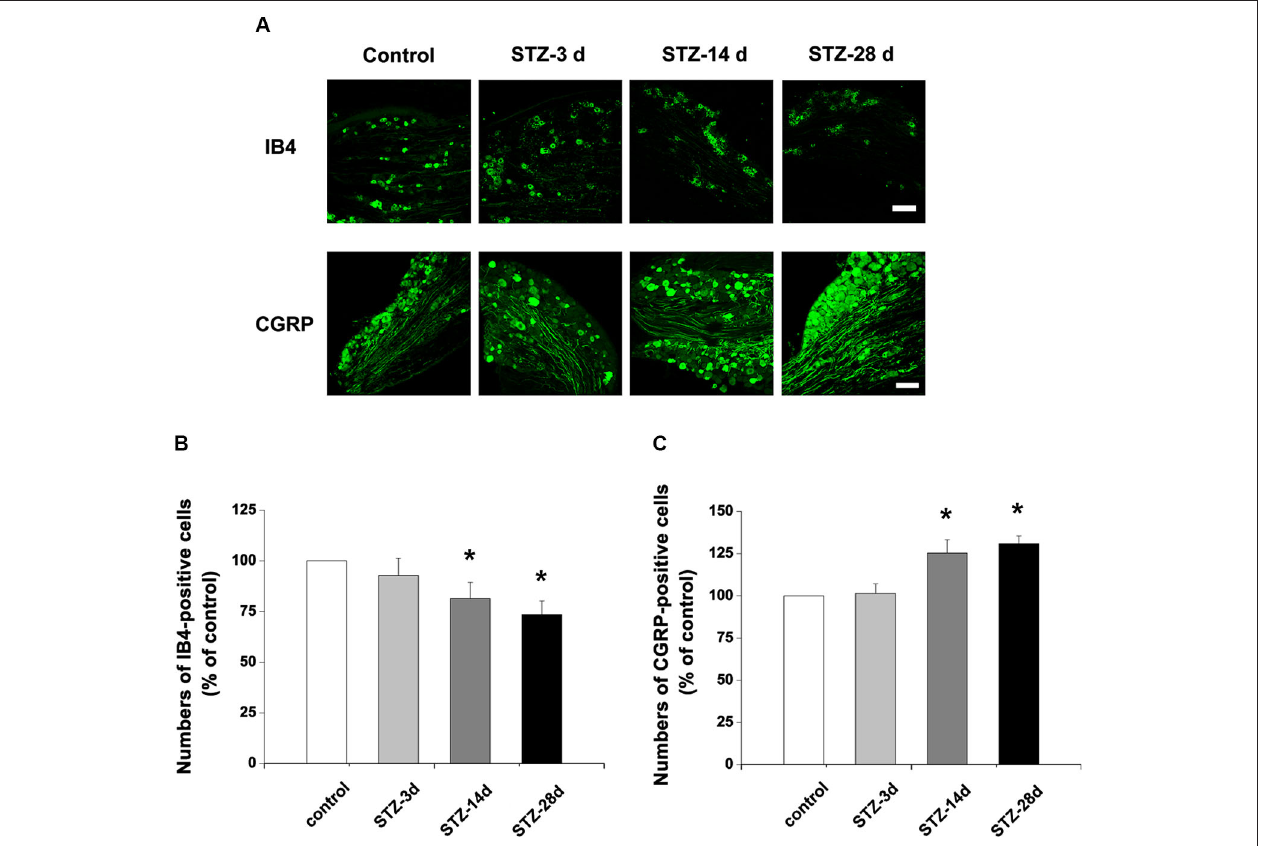
groups. Values are normalized, with the mean of the control group set as 100%. Mean ± SD, n = 6 rats in each group. * P < 0.05, comparing diabetic rats with non-diabetic control